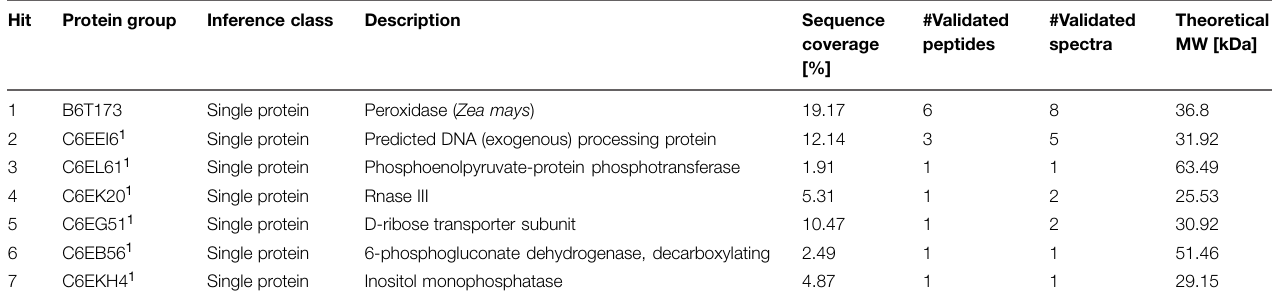
IMAC affinity purification. (B) Coomassie R-250 staining of the POD active fractions. (C) Guaiacol-H 2 O 2 staining of the same POD fractions. In all cases, 20 µ L of protein solution were loaded. Arrows indicate bands with POD